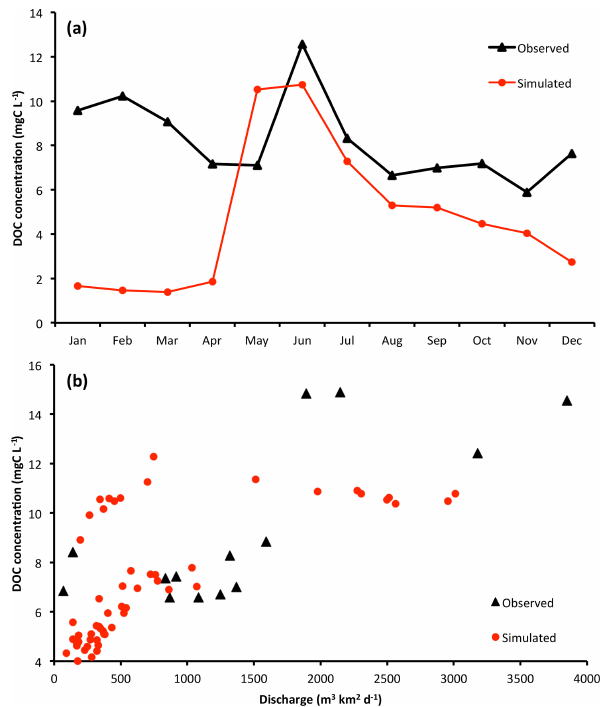
Figure 5. (a) Simulated and observed (Arctic-GRO; Holmes et al., 2012) DOC concentration seasonality for the Lena basin over the period 1999–2007. (b) Plots of DOC concentration versus river dis- charge as in observations (Raymond et al., 2007) and simulations, where simulation data points are monthly averages taken over the period